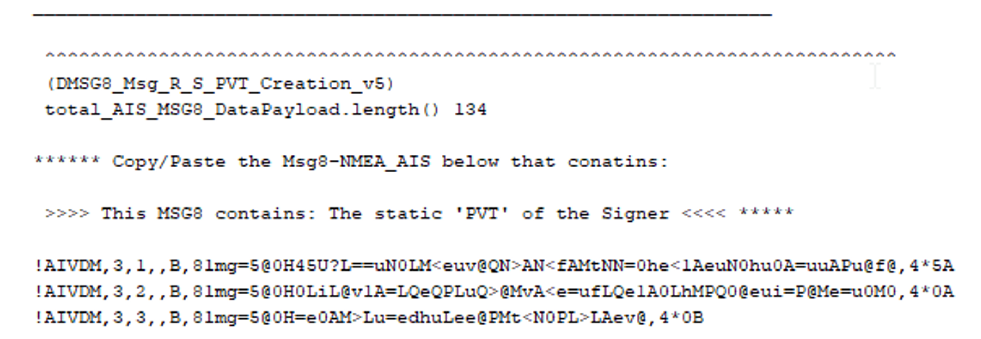
Figure 5. ID8 AIS message that encapsulates the PVT part of the signature.